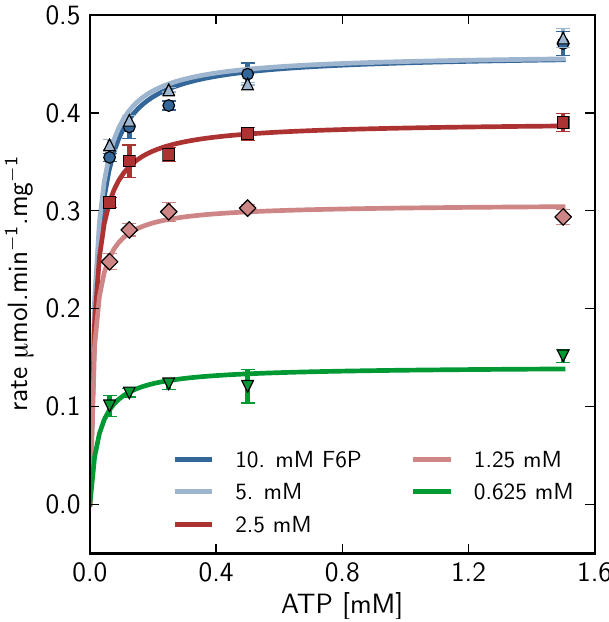
Figure 8. Phosphofructokinase enzyme-coupled kinetic assay. ATP saturation curves at di ff erent F6P concentrations were generated using the coupled enzyme assay system as described in Section 3.5. Points represent initial rate data and are fitted with a standard irreversible Michaelis–Menten kinetic equation. Error bars represent experimental replicates ( n = 3) and are S.E.M. F6P: 10 mM ( - • - ), 5 mM ( - (cid:78) - ), 2.5 mM ( - (cid:4) - ), 1.25 mM ( - (cid:95) - ), 0.625 mM ( - (cid:72) -